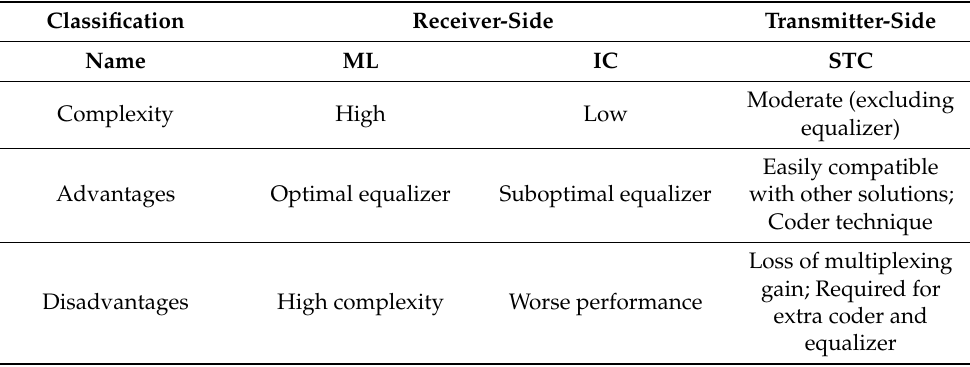
Table 2. Comparison between different digital solutions for mitigating MDL